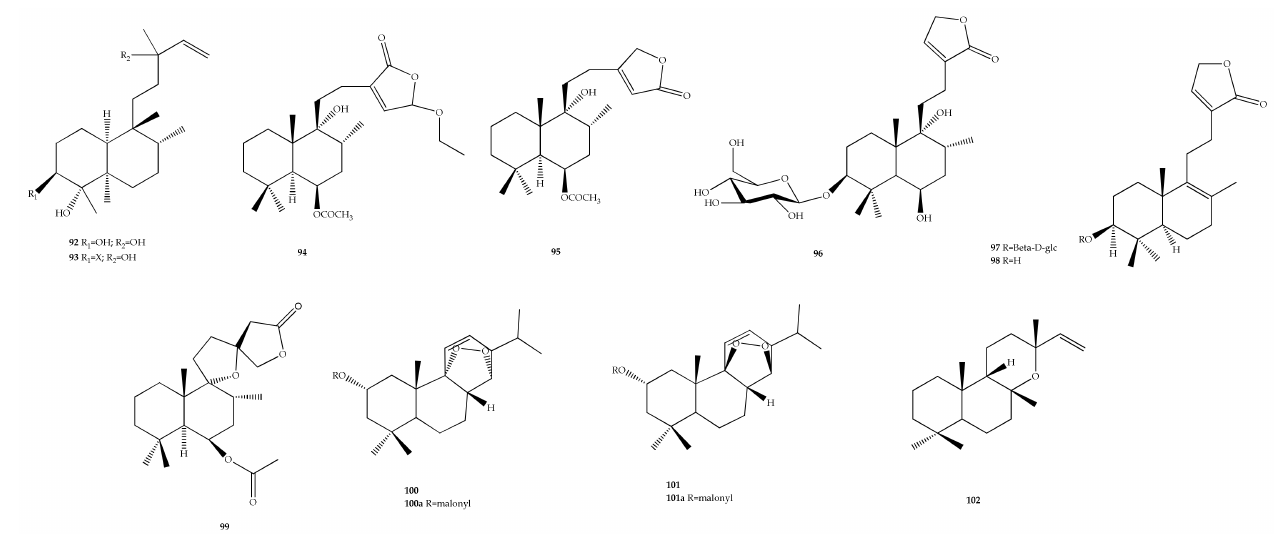
Figure 4. Chemical structures of diterpenoids 25 – 102 found in Vitex